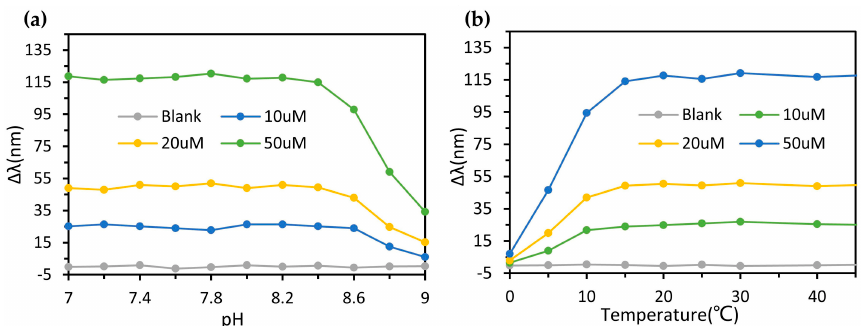
Figure 6. SPR peak shift of triangular silver nanoprisms under different conditions. ( a ) SPR peak shift of Ag nanoprisms versus pH value of sample water. ( b ) SPR peak shift of Ag nanoprisms versus incubation temperature.